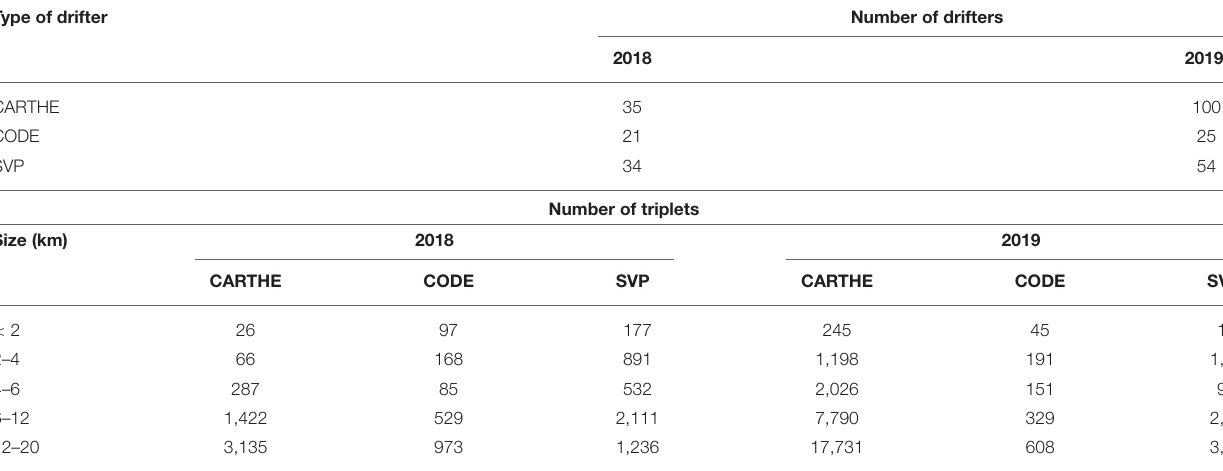
TABLE 1 | Top : number of drifters during the two CALYPSO experiments in May 28 - June 29, 2018 and March 28 - April 29, 2019. Type of drifter